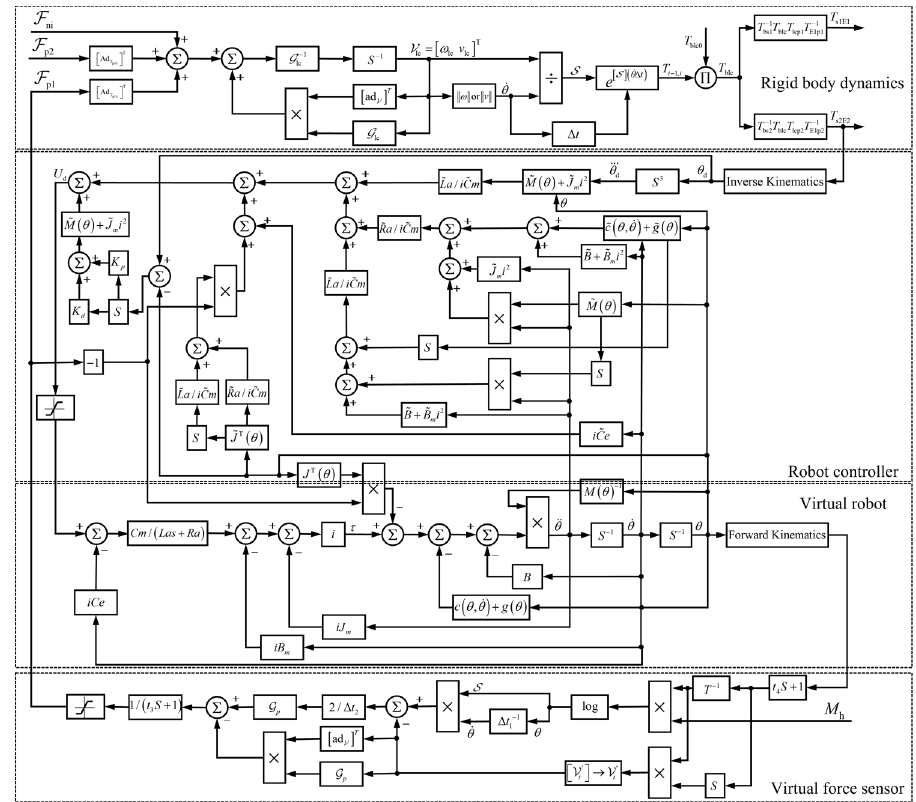
Figure 4. Virtual force sensor system block diagram.